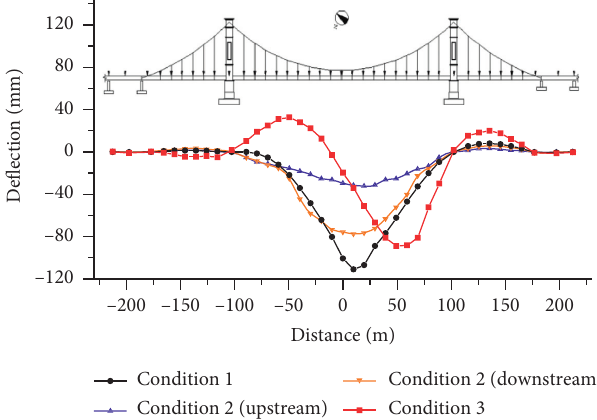
Figure 9: Longitudinal distribution of deflection.